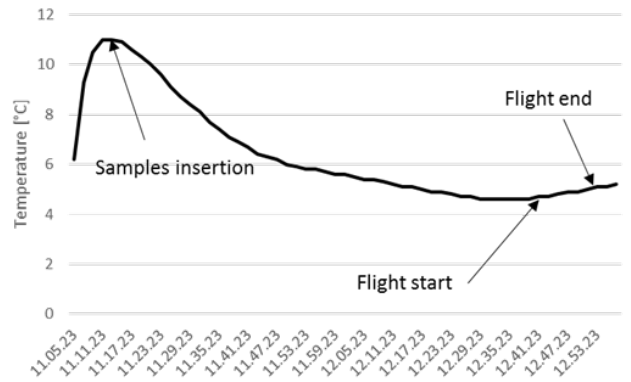
Figure 7. Temperature variation of the samples during the entire experiment, where the x axis represents the experimental time (h.min.s) with a fixed interval of 6